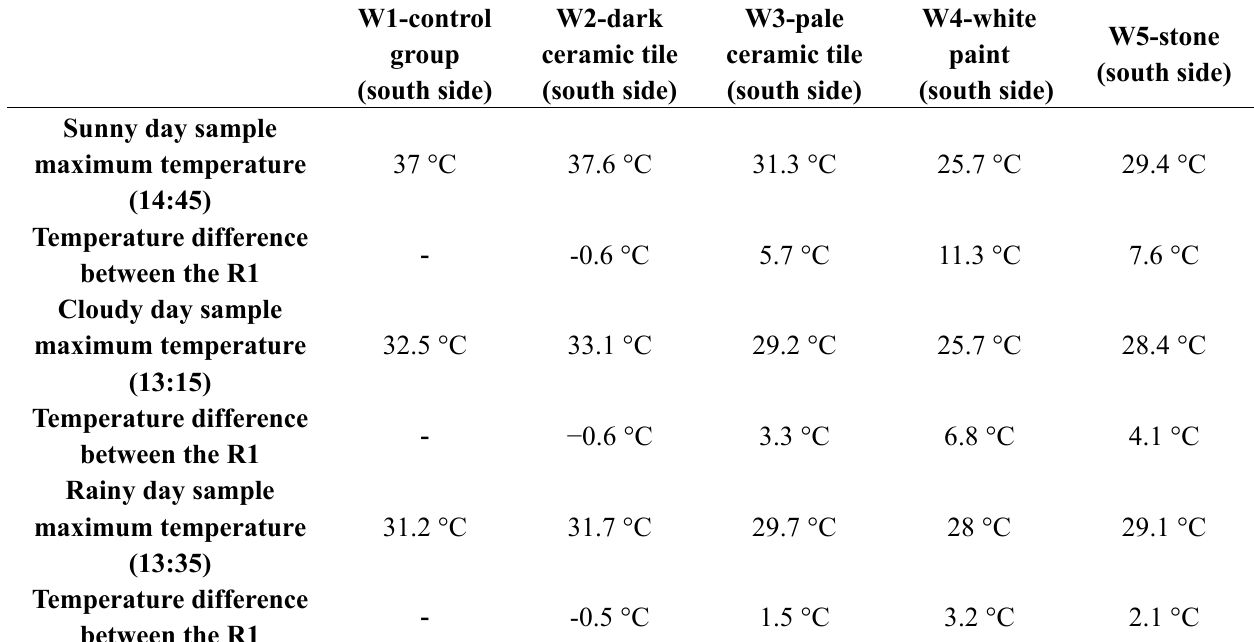
Table 5. Efficacy comparison of outer-wall thermal insulation materials under different weather